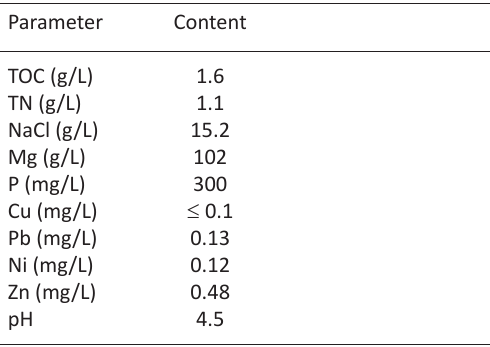
Table 1. Physiochemical characteristics of landfill leachate.